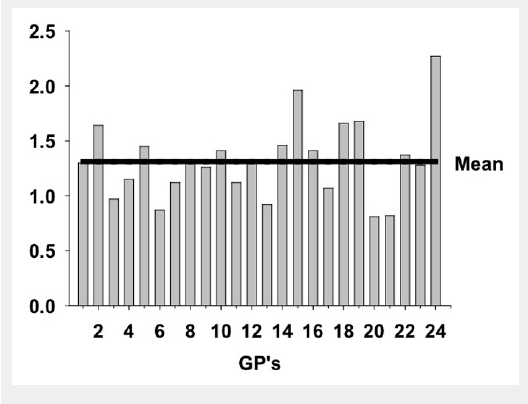
Figure 2 Number of ICPC-2 codes per consultation (y-axis) of each GP (x- axis). The index shows variation across participants ranging between 0.55 and 1.78 with a mean of